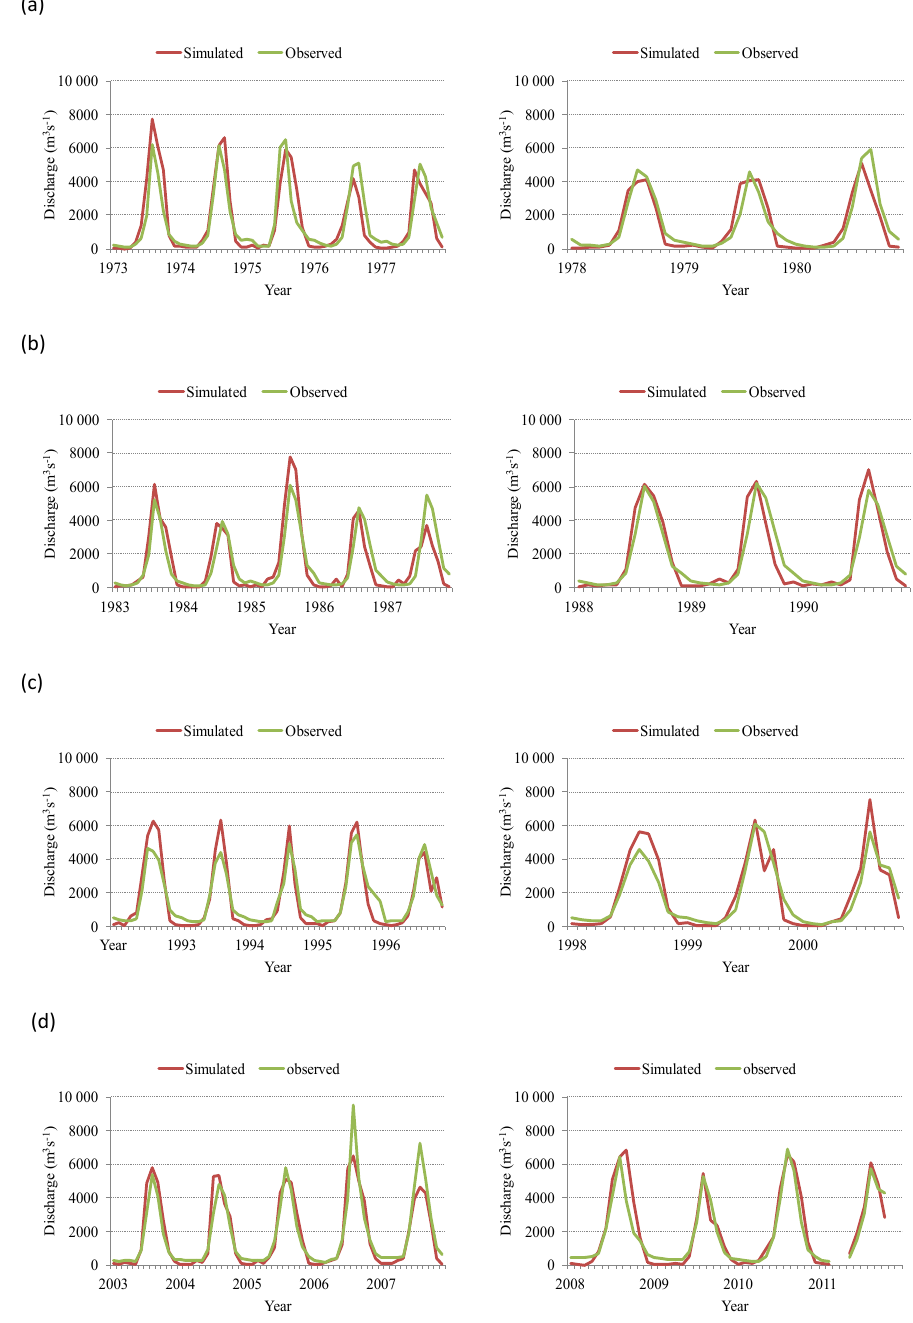
Figure 6. Calibration and validation of the SWAT hydrological model (left and right, respectively) at monthly timescale: (a) 1970s, (b) 1980s, (c) 1990s, and (d)